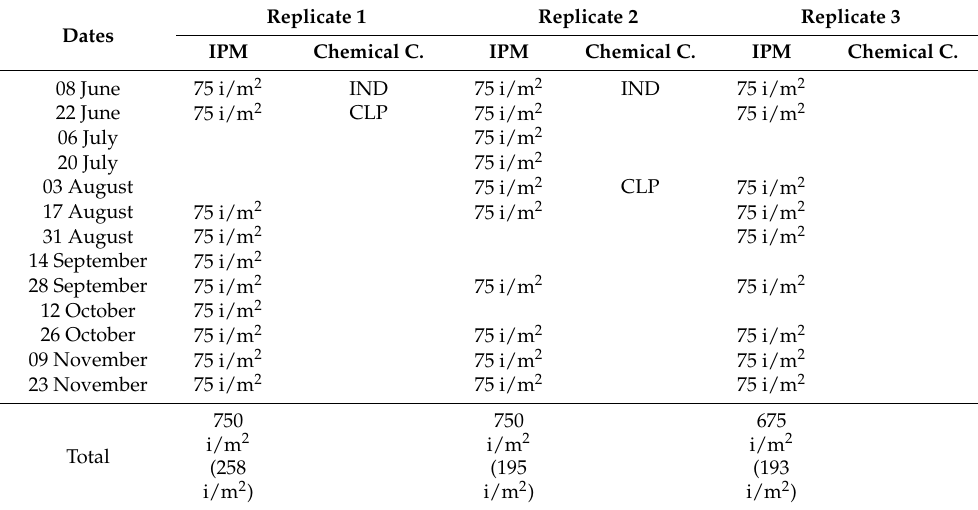
Table 3. Timing and expected and real (between brackets) rates for T. achaeae releases (insects/m 2 ) (i/m 2 ) and insecticide applications in each plot in 2016 trials.